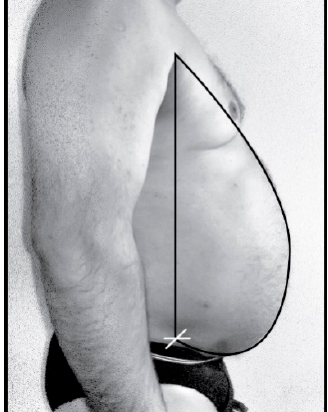
Figure 2. Thoracic ‐ abdominal profile image acquisition.